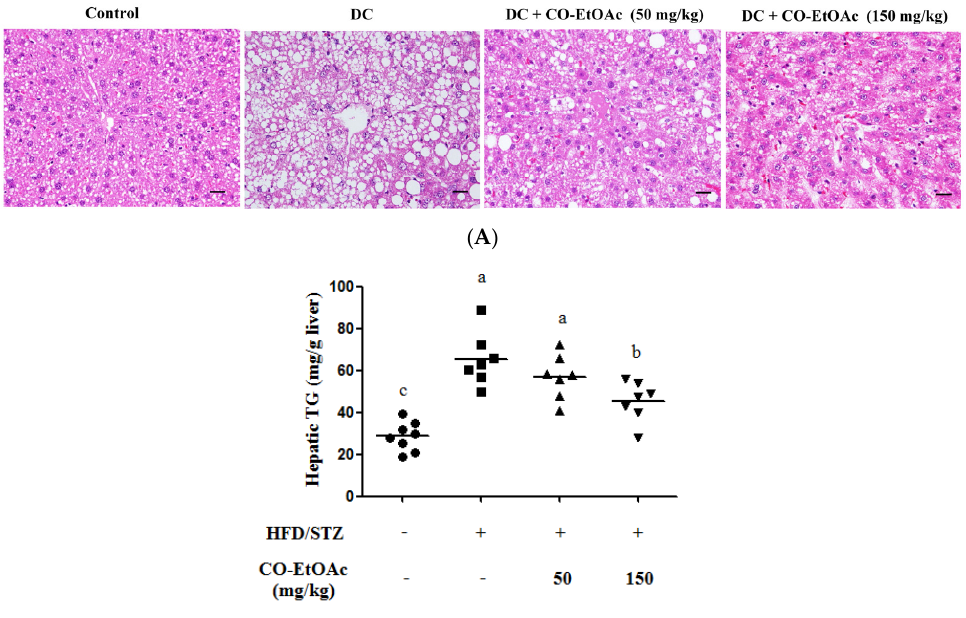
Figure 3. Effects of OE ‐ EtOAc on hepatic lipid accumulation. ( A ) The sections of rat liver tissues were stained by H&E with a representative photograph under 200× magnification; scale bar represents 30 μ m. ( B ) The triglyceride content was analyzed using enzymatic assay. Data are represented as mean ± SEM ( n = 8–10). Values with different letters indicate statistical difference ( p < 0.05) by analysis of variance (ANOVA) followed by Duncan’s multiple range tests.